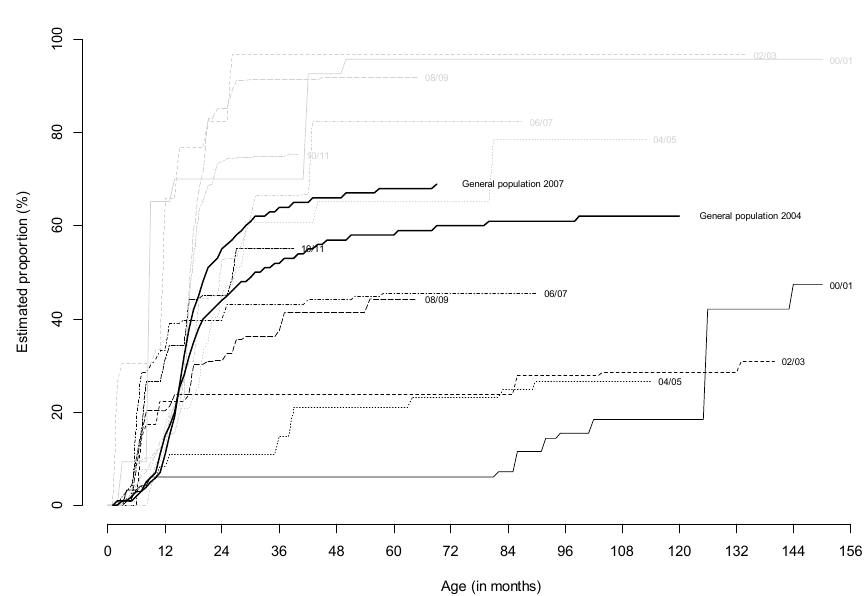
Figure 3. Estimated cumulative proportion of children receiving three doses of hepatitis B according to age (in months) and birthplace in France (gray curves) or outside France (black curves) and according to birth cohort: 2000/01 (solid lines), 2002/03 (dashed lines), 2004/05 (dotted lines), 2006/07 (dot-dash lines), 2008/09 (long-dash lines), 2010/11 (two-dash lines). Note: each point corresponds to the proportion of vaccinated children at a given age.